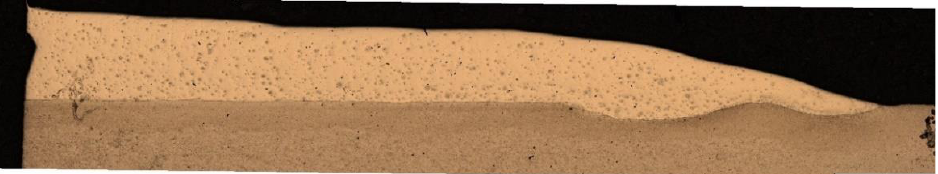
Figure 5. Macrostructure of INCONEL 718 coating cladded on 16Mo3 steel tube, average thickness 1.7 mm (×25).